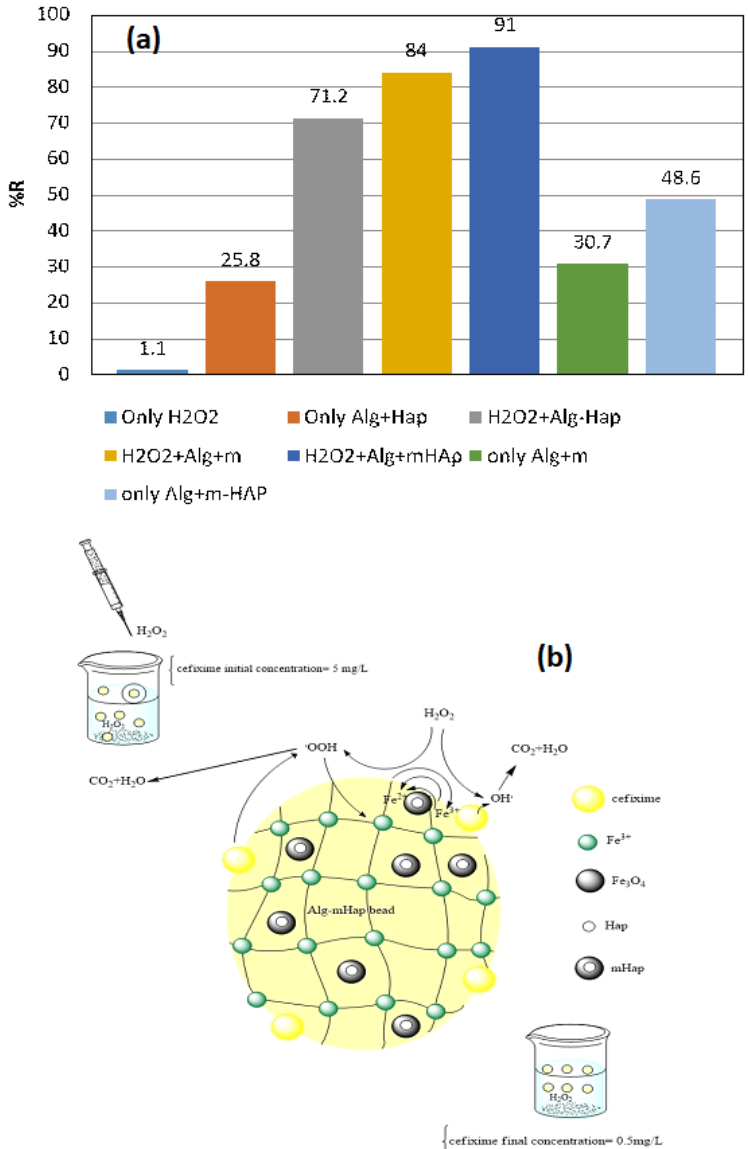
Fig. 10. (a) Comparison of different methods for removal cefixime removal (in optimal conditions) (b) The schematic of the proposed cefixime degradation by Alg-mHAp catalyst in the Fenton process.